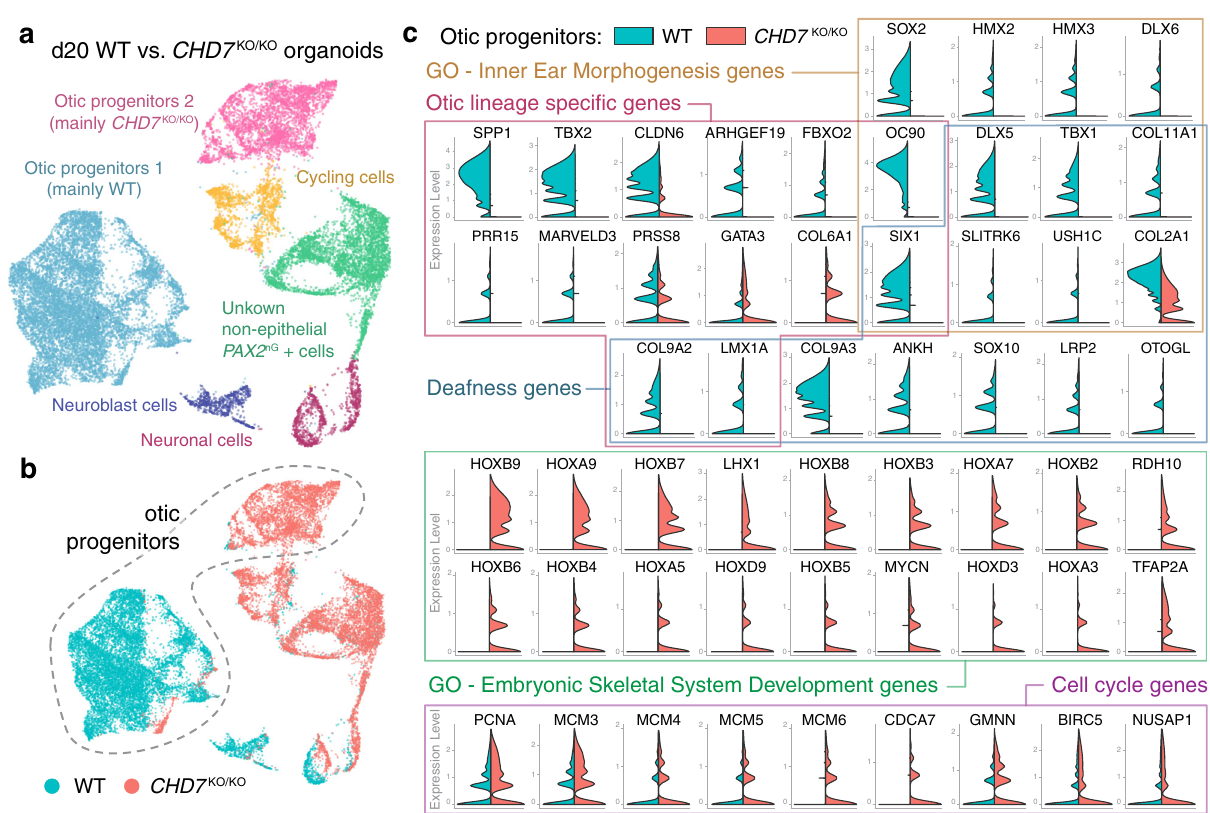
Fig. 3 | scRNA-seq of d20 WT and CHD7 KO/KO organoids revealed critical role of CHD7 in otic development. a , b Uniform manifold approximation and projection (UMAP)plotandclusterannotationofFACS-isolated PAX2 nG -positivecellsfromd20 WT and CHD7 KO/KO organoids as grouped by cluster ( a ) or by genotype ( b ). Dotted